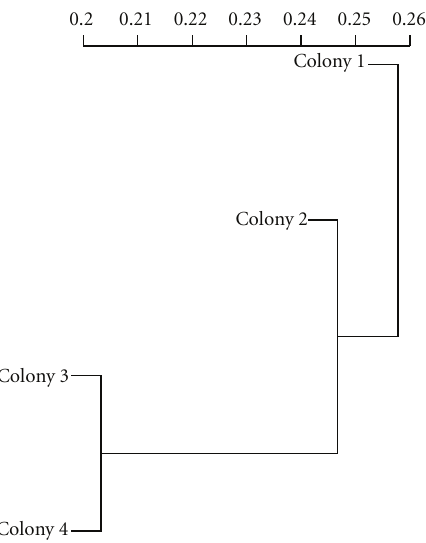
Figure 8: Dendrogram based on qualitative similarity of the pollen collected by 4 colonies in the study period. Distances are Sørensen Index; clustering was done with